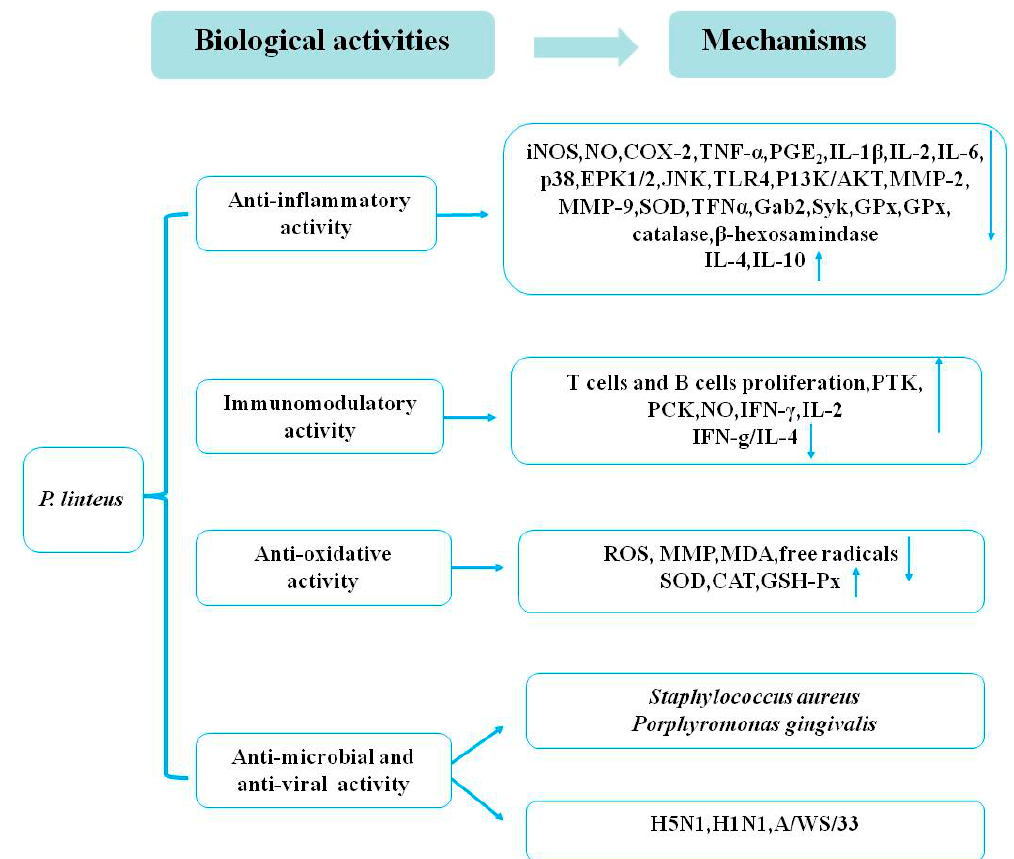
Figure 3. The biological activities of P. linteus and their mechanisms.